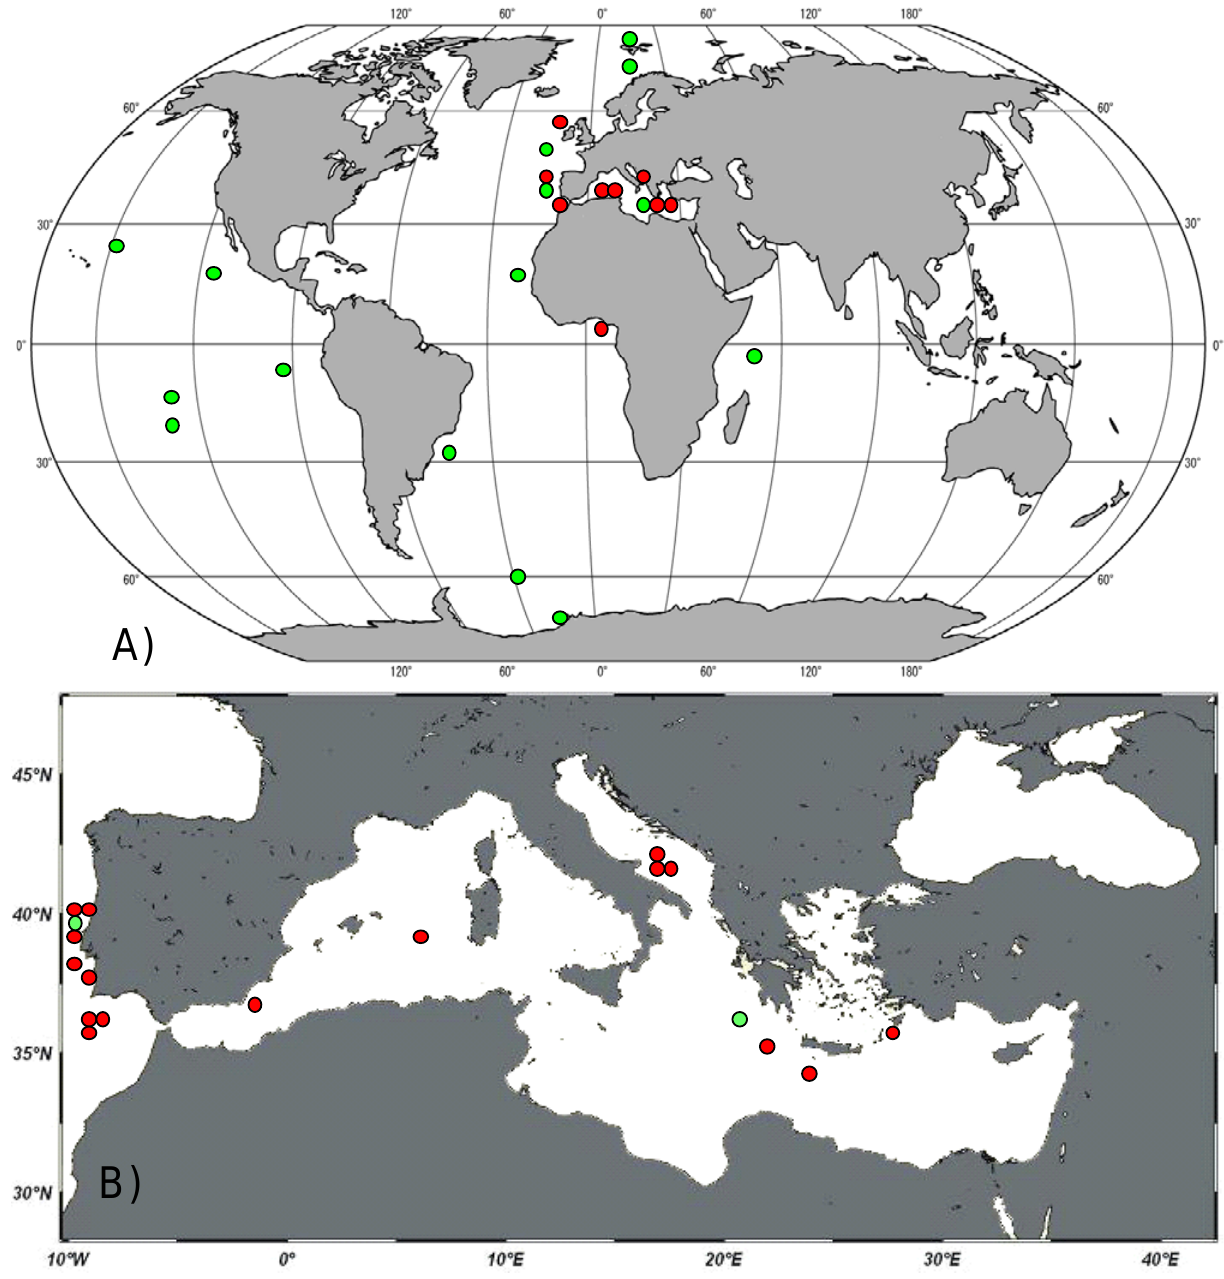
Figure 1. Geographic distribution of the genus Manganonema at global scale ( A ) and in the Mediterranean Sea ( B ). Red circles indicate locations of Manganonema records in the present study, green circles indicate Manganonema records available in literature (Antarctic Ocean [ 28,29 ] , Arctic Ocean [ 33 ] , Atlantic Ocean [ 29,30,32 ] , Barents Sea [ 34 ] , Pacific Ocean [ 24,26,27,29,35 ] , Mediterranean Sea [ 31 ] , Weddell Sea [ 25 ]